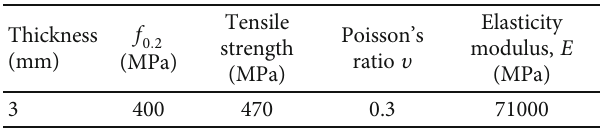
Table 3: Material properties of aluminum